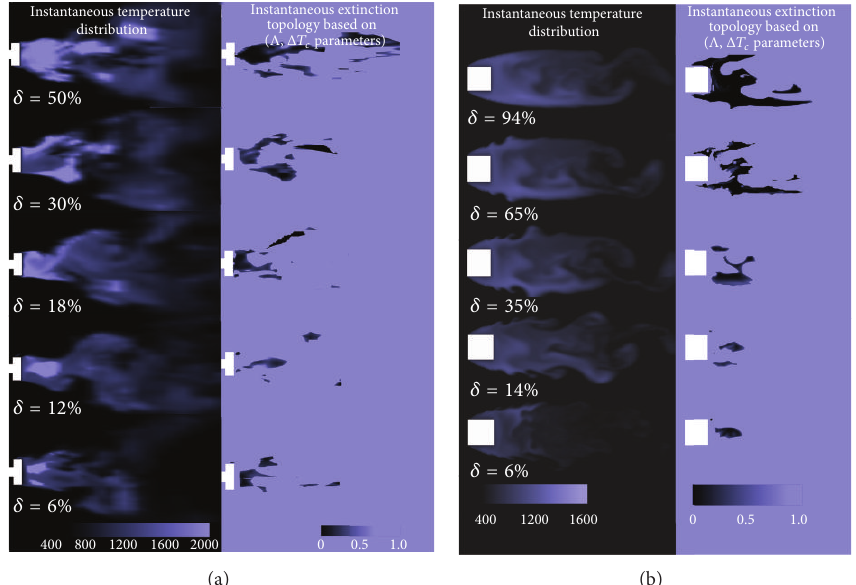
Figure 7: Snapshots of temperature and extinction topologies for a range of simulated flame settings as LBO is approached, (a) disk and (b) square